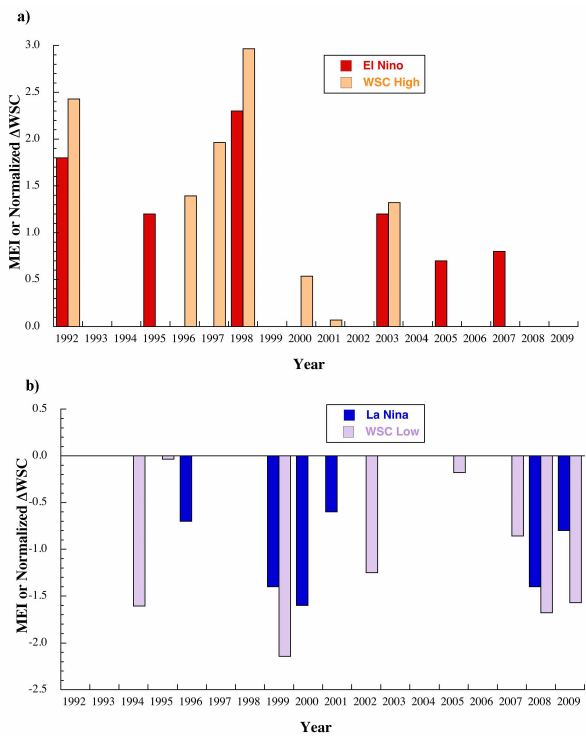
Fig. 4. December–January–February (DJF) averages of (a) MEI during El Ni˜no along with corresponding values of normalized 1 WSC where 1 WSC was high and (b) MEI during La Ni˜na events along with corresponding values of normalized 1 WSC where 1 WSC was low. Normalized values were computed by dividing by the standard deviation. Also shown are years where the normal- ized 1 WSC exceeded ± 1, even if there was no El Ni˜no or La Ni˜na event. Note that the year indicated represents the year for January of the average. Hence, the 1997/1998 El Ni˜no is in